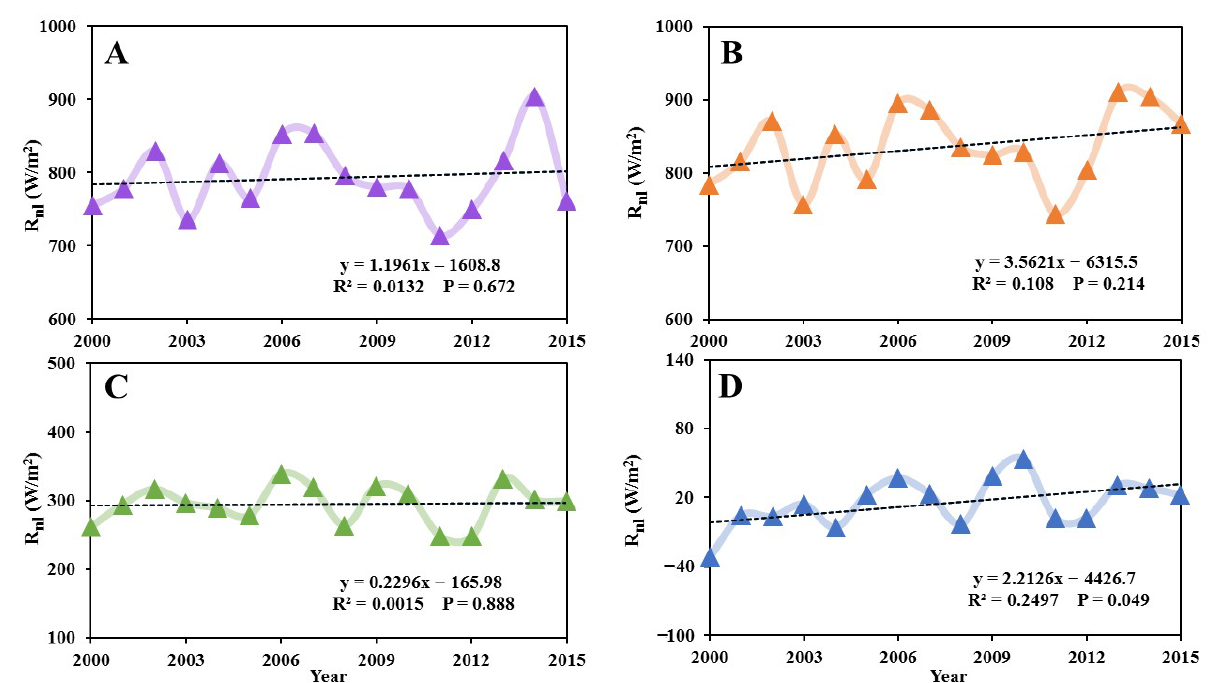
Figure 12. Trend of longwave radiation from 2000 to 2015 (( A ): Jinan City, ( B ): Zhengzhou City, ( C ): Lanzhou City, ( D ): Xining